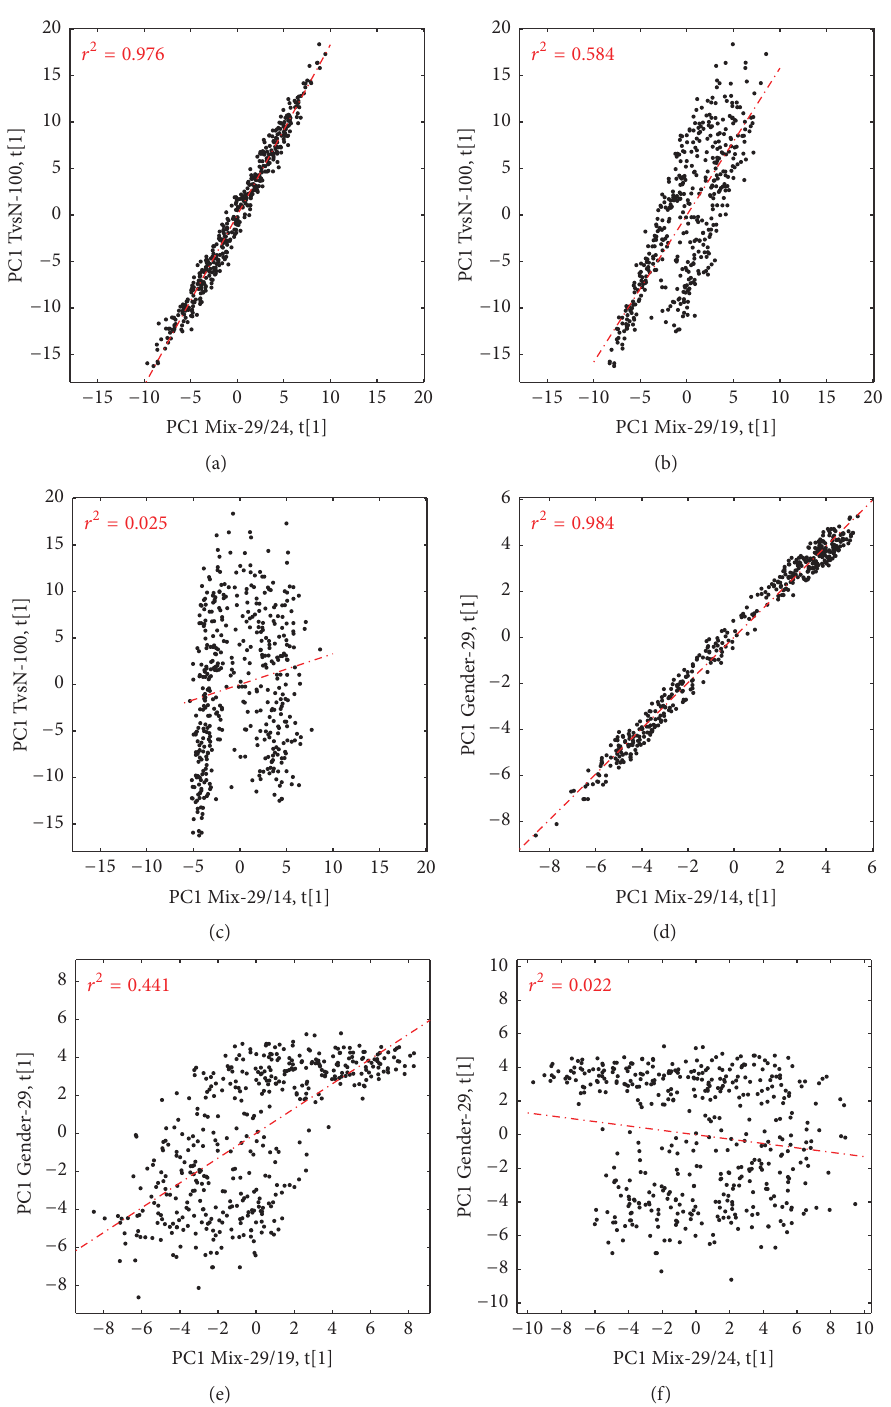
Figure 6: Correlation between the PCA scores from different mixed-gene signatures and the Gender-29 and TvsN-100 signature applied to the DC dataset. Even when five TvsN probesets are removed, the Mix-29/24 model is still correlated with the TvsN-100 signature (a). This correlation further decreases when more probesets are removed (b), until it is finally gone (c). The Mix-29/14 signature is, instead, correlated with the Gender-29 signature (d). The Gender-29 signature is less correlated with the Mix-29/19 signature (e) and shows no correlation with the Mix-29/24 signature